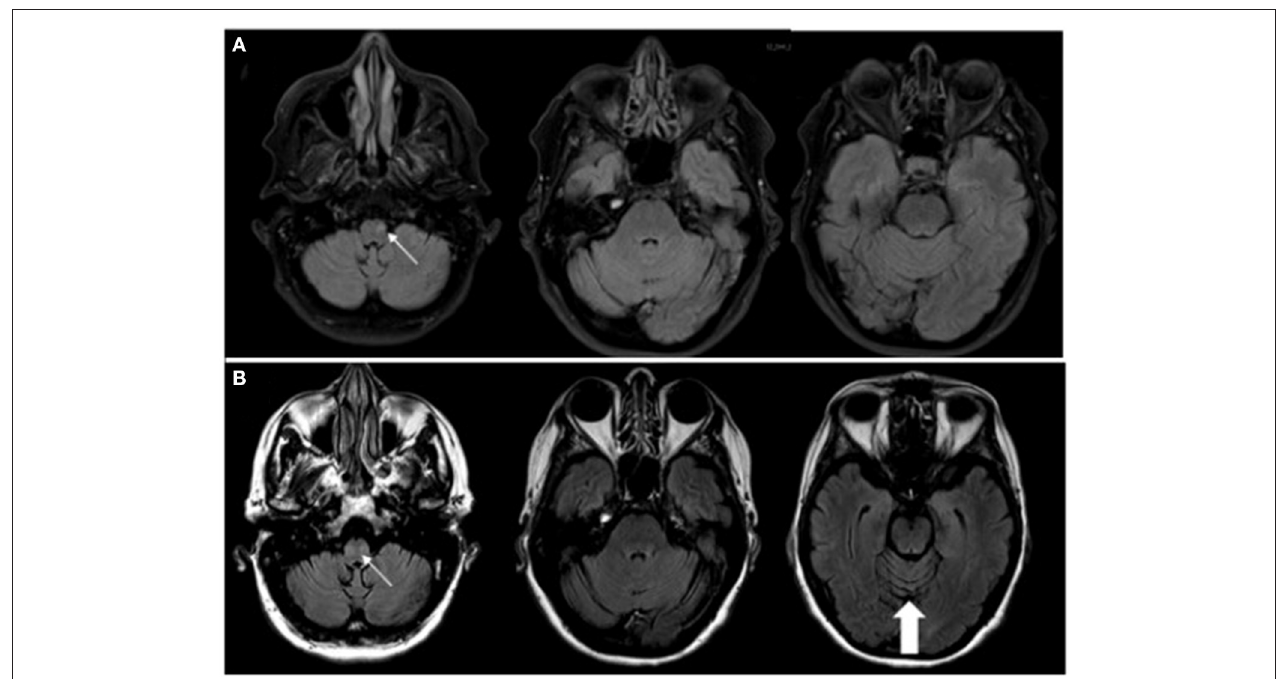
FIGURE 2 | (A) MRI sequences of T2/FLAIR (fluid-attenuated inversion recovery) with STIR (short tau inversion recovery; i.e. fat suppression) at the onset of neurological symptoms of vertigo and ataxia demonstrating a small T2, non-enhancing lesion (contrast imaging not shown) in the left medulla (thin, white arrow). (B) with T2/FLAIR MRI 3 months later demonstrating T2 changes seen bilaterally within the medulla (thin, white arrow) with no associated contrast enhancement. There is noted cerebellar atrophy, particularly seen in the superior cerebellum (thick, white arrow), compared to the MRI from 3 months